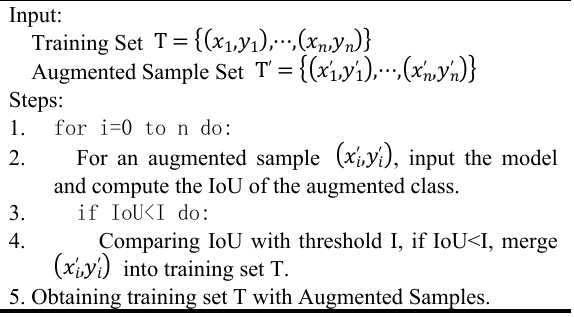
Fig.2 Overall Architecture of the Deep Learning Model 2.2 Multi-model Integration Algorithm for Classification